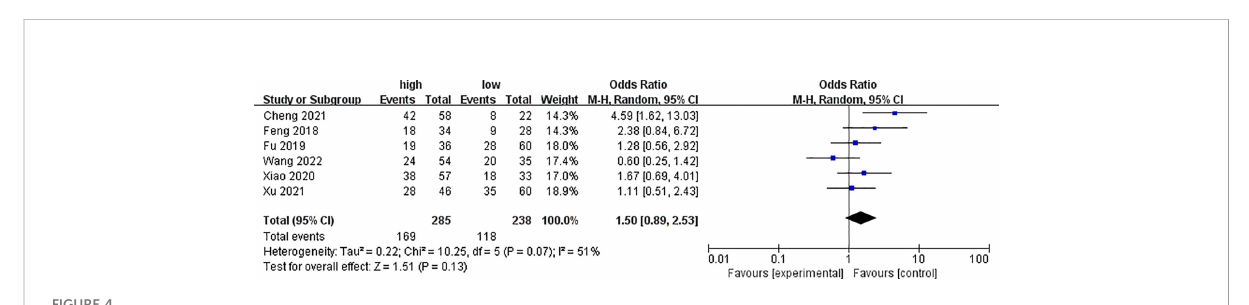
FIGURE 4 Forest plot of meta-analysis of the relationship between PYCR1 expression and cancer size.